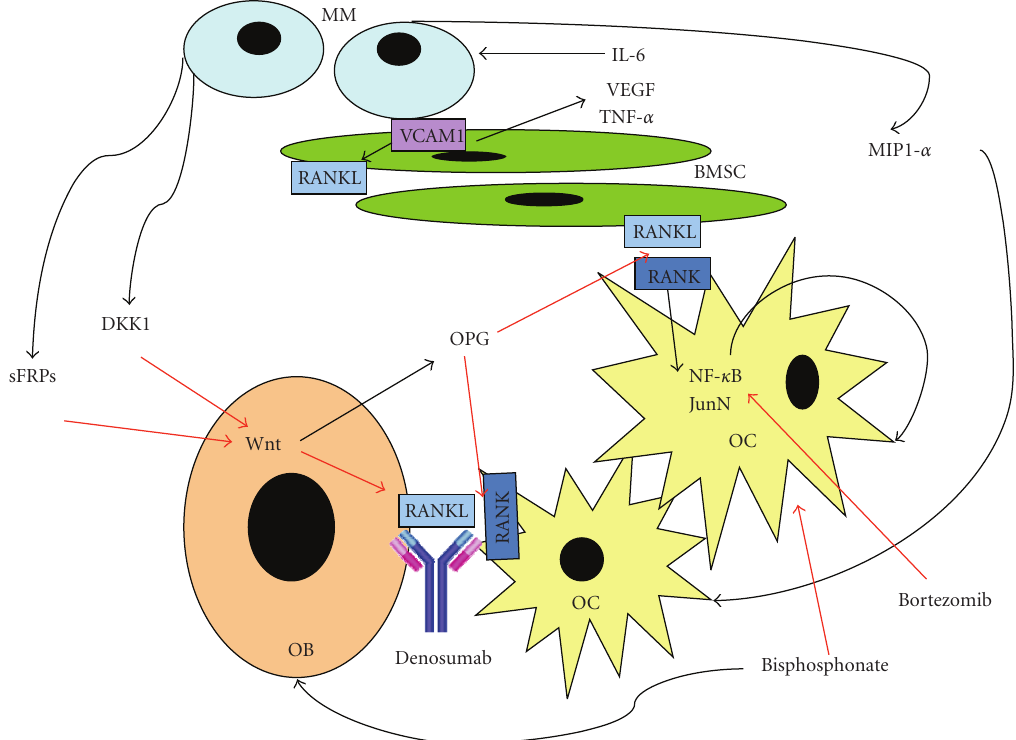
Figure 1: Pathophysiology of myeloma bone disease. Black arrows indicate increased production or activation, and red arrows indicate decreased production or inhibition. Normal bone metabolism involves the constant rebuilding of bone by osteoblasts and resorption of bone by osteoclasts, intricately balanced through appropriate cytokine signaling (usually associated with an increased OPG to RANKL ratio). The presence of myeloma cells in the bone marrow milieu results in upregulation of osteoclastic activity compared with osteoblastic bone formation resulting in lytic lesions. The malignant plasma cells interact with stromal cells, causing increased cytokine signaling through IL-6 and TNF- β . This results in increased RANKL expression by bone marrow stromal cells, stimulation of plasma cell growth, and drug resistance. In addition, malignant plasma cells produce inhibitors of Wnt signaling (DKK1 and sFRPs). Wnt inhibition results in downregulation of OPG production and upregulation of RANKL. The interaction of RANK with its ligand (RANKL) leads to osteoclast activation via signaling by NF- κ B. In addition, malignant plasma cells produce MIP-1 α , which directly stimulates osteoclasts. Therapy with bisphosphonates results in osteoclast inhibition and osteoblast activation. The novel monoclonal antibody, denosumab, which neutralizes RANKL, is currently the subject of clinical investigations for bone disease therapy in patients with multiple myeloma. MM: multiple myeloma, IL-6: interleukin 6, VEGF: vascular endothelial growth factor, TNF- α : tumor necrosis factor- α , BMSC: bone marrow stromal cell, MIP-1 α : macrophage inhibitory protein-1 α , OB: osteoblast, OC: osteoclasts, OPG: osteoprotegerin, DKK1: dickkopf, sFRPs: serum frizzle related proteins, VCAM-1: vascular cell adhesion molecule-1, RANK: receptor activator for nuclear factor κ B, JunN: c-Jun N-terminal protein kinase, Wnt, Wnt glycoproteins (bind to